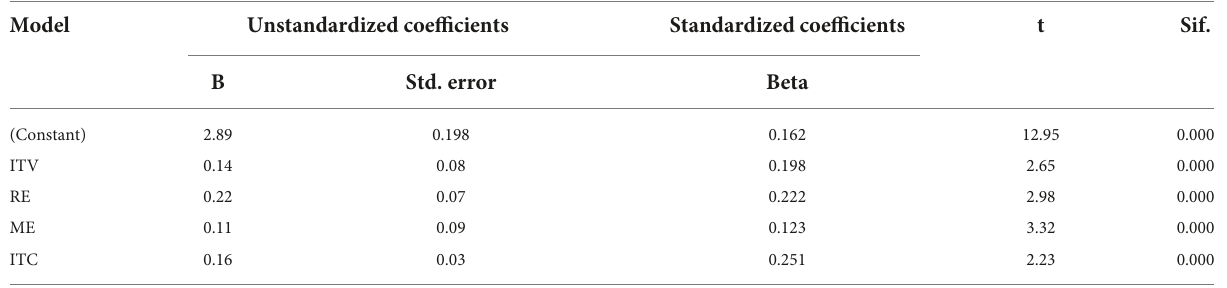
TABLE 5 Regression test